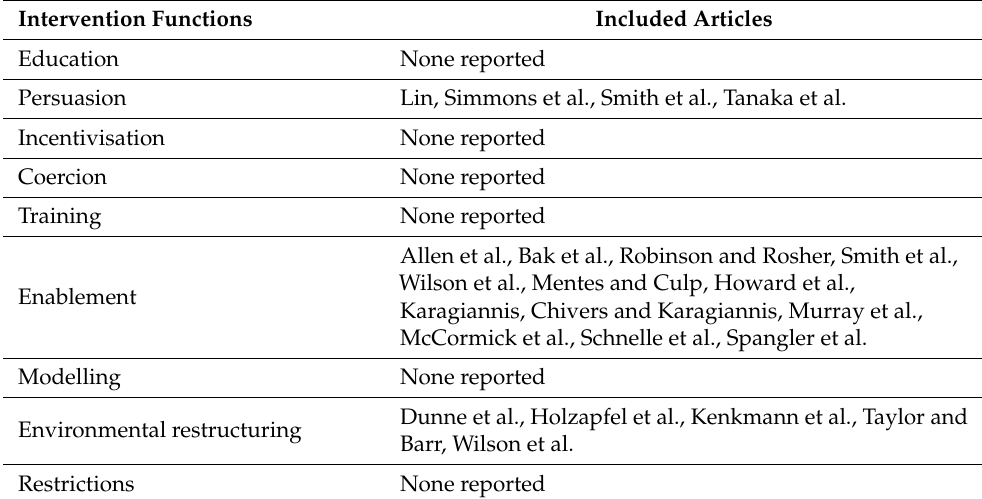
Table 4. Characterisation of interventions using categories from the Behaviour Change Wheel